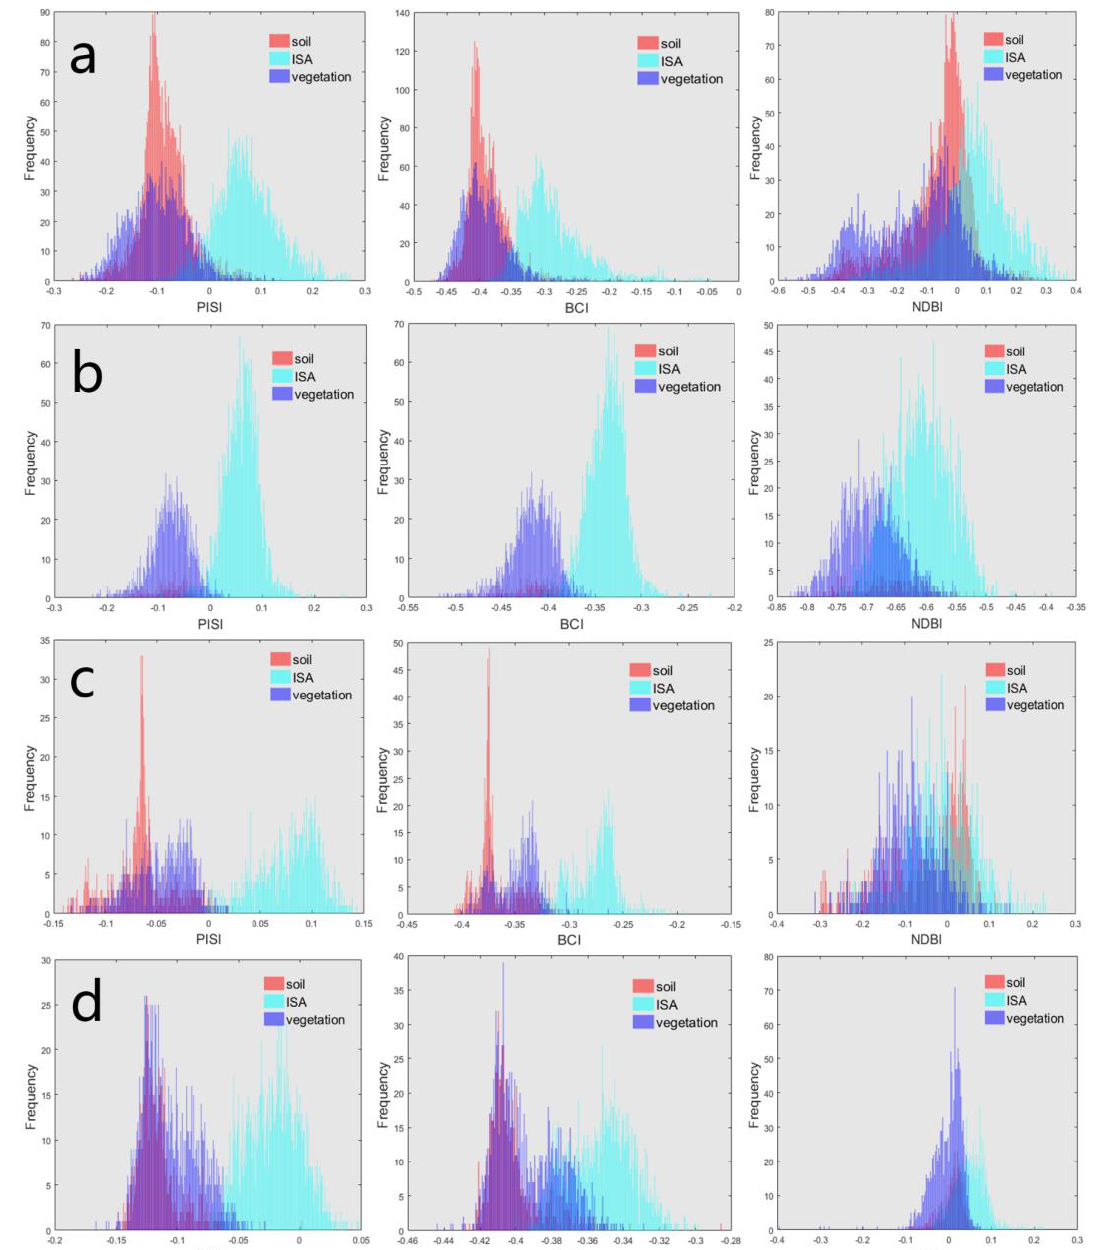
Figure 14. Histograms of values of different indices for each component (ISA, soil, and vegetation) in the four subregions: ( a – d ) the results of the four subregions in Figure 7. The three columns, from left to right, are PISI, BCI, and